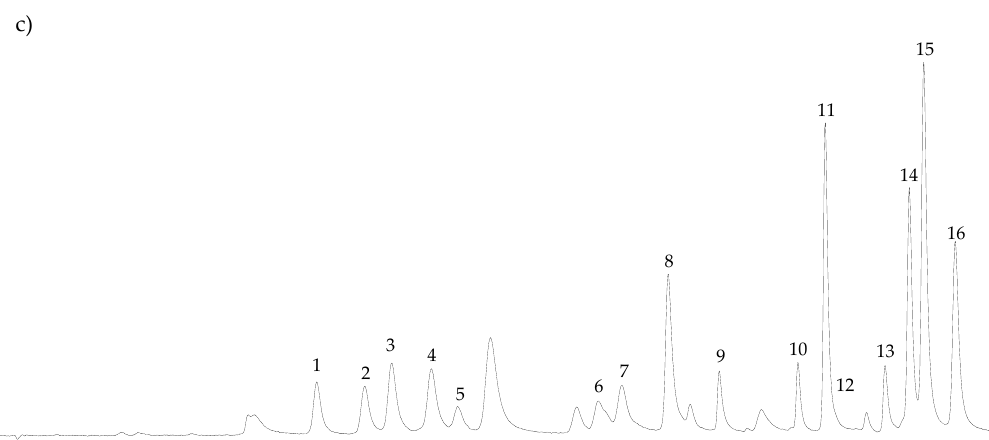
Figure 1. Chromatograms for the amino acid analysis: ( a ) fillet; ( b ) skin; ( c ) liver.